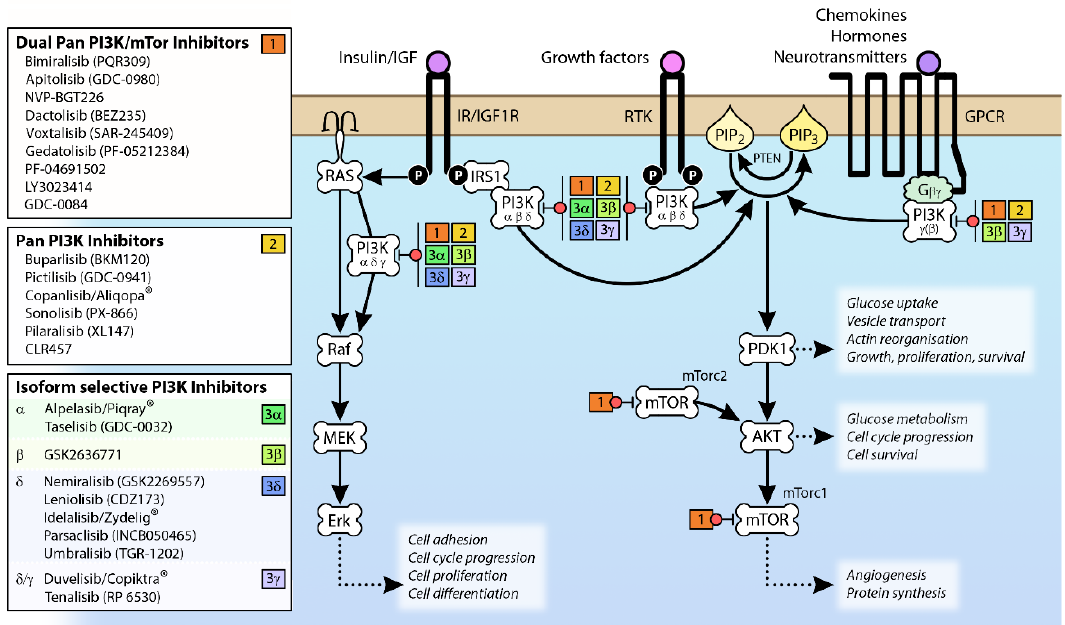
Figure 2. Signaling pathways activated by different isoforms of Class I PI3K and PI3K inhibitors that target specific components of these pathways. Class 1a isoforms of PI3K are attracted to the membrane by the activation of RTKs (including IR / IGF1R), while PI3K γ (and to a lesser extent PI3K β ) is recruited by GPCR activation. The membrane proximity of PI3K results in the phosphorylation of membrane-bound PIP2 to PIP3, which mediates the activation of downstream protein kinases involved in a wide range of cellular processes. The various pan PI3K and isoform-specific inhibitors listed are ≥ Phase 2 clinical trial according to www.clinicaltrials.gov (accessed August 2019). Abbreviations: AKT, Protein kinase B; Erk, extracellular signal-regulated kinase; GPCR, G-protein coupled receptor; IGF1R, insulin-like growth factor 1 receptor; IRS1, insulin receptor; MEK, MAPK / ERK kinase; mTOR, mammalian